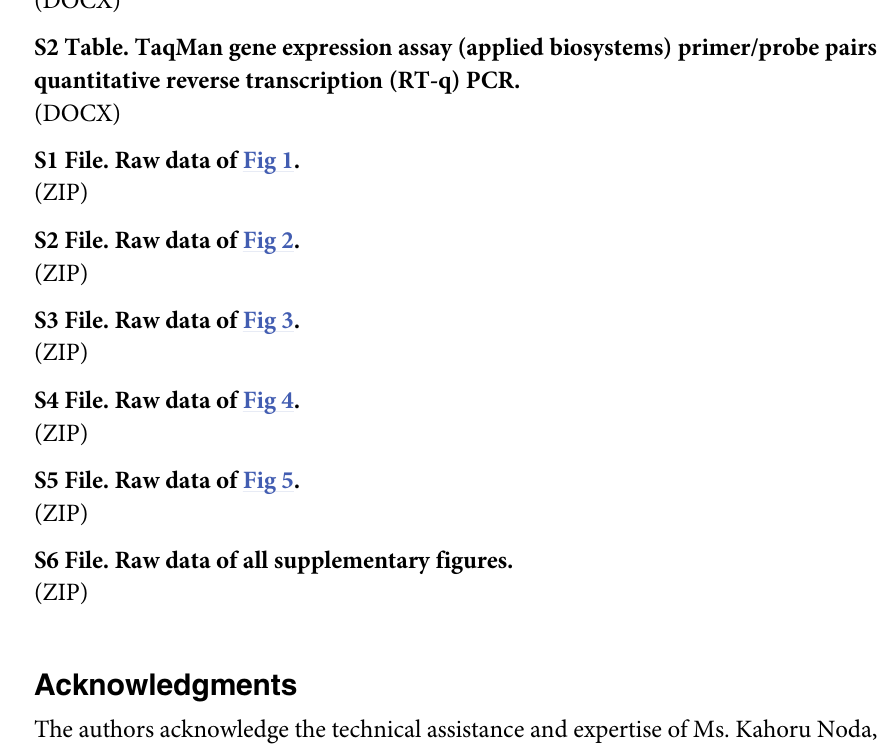
S12 Fig. Schematic cartoon showing the potential function of EBI3 during chondrogenesis in human MSCs under different conditions. In normal condition, EBI3 exists in the early stage and maintain the ER stress. While low ER stress caused by EBI3 knockdown or excessive ER stress induced by overexpression of EBI3 result in the inhibition of chondrogenesis. In RA condition, high expression of EBI3 induced by inflammatory cytokines contributes to exces- sive ER stress and suppression of chondrogenesis. S1 Table. Key resources table. S2 Table. TaqMan gene expression assay (applied biosystems) primer/probe pairs for quantitative reverse transcription (RT-q)